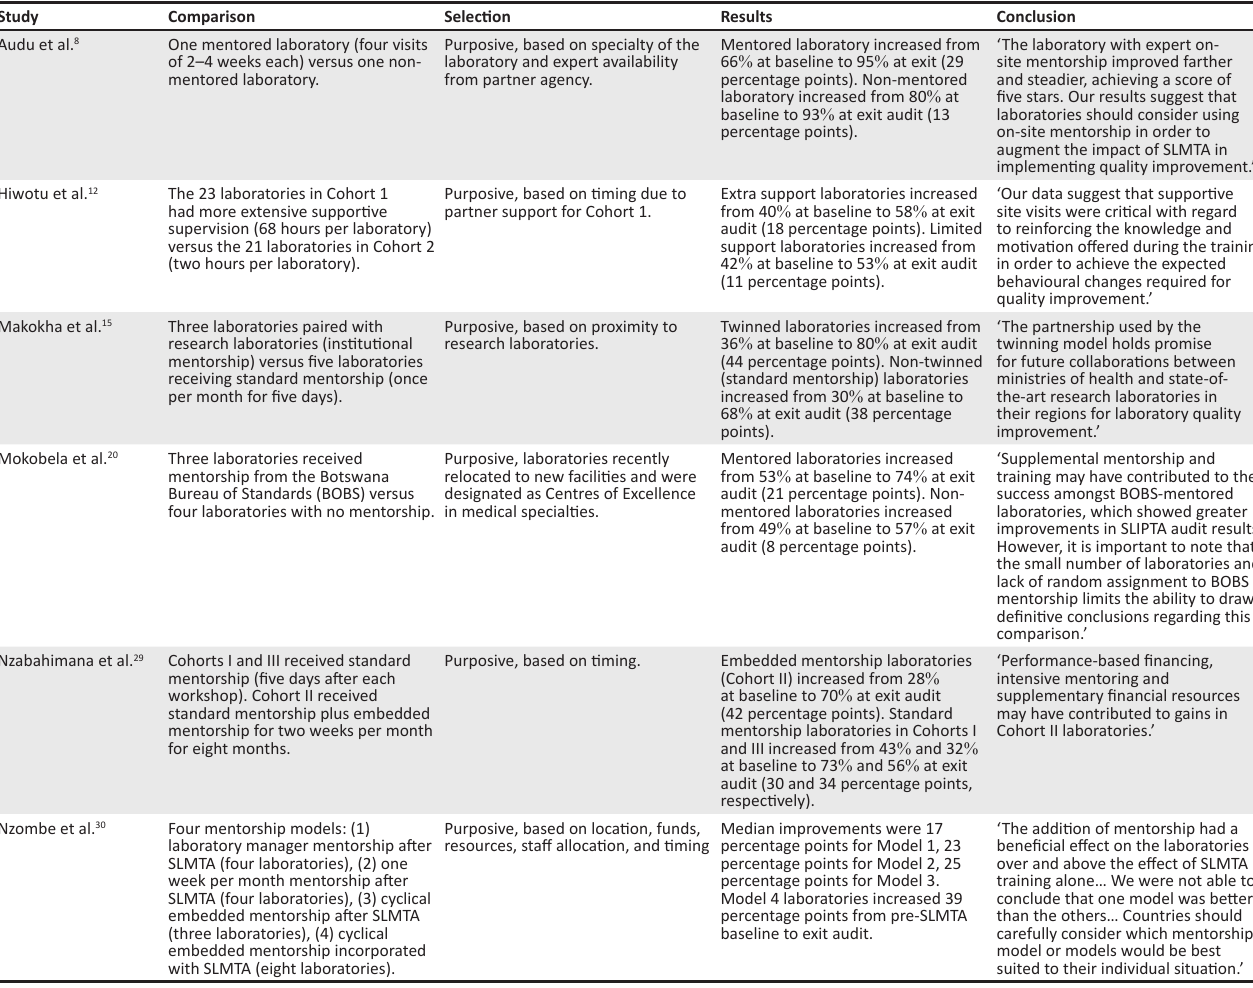
TABLE 3: Mentorship models reported by SLMTA